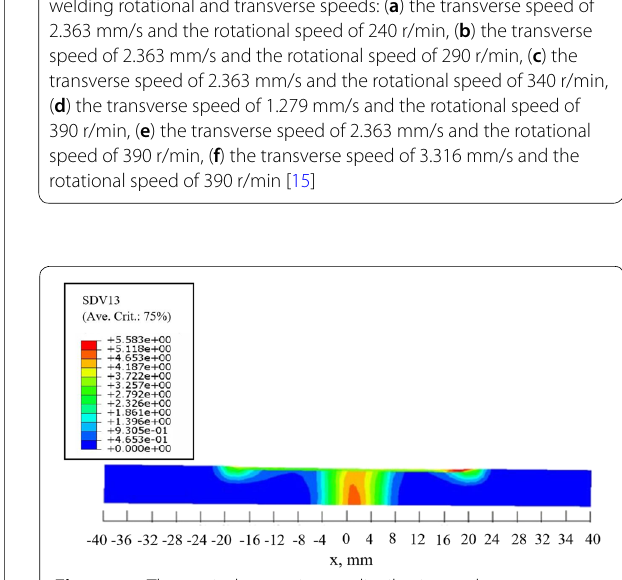
Figure 51 The equivalent strain rate distribution at the tool-workpiece interface [15]